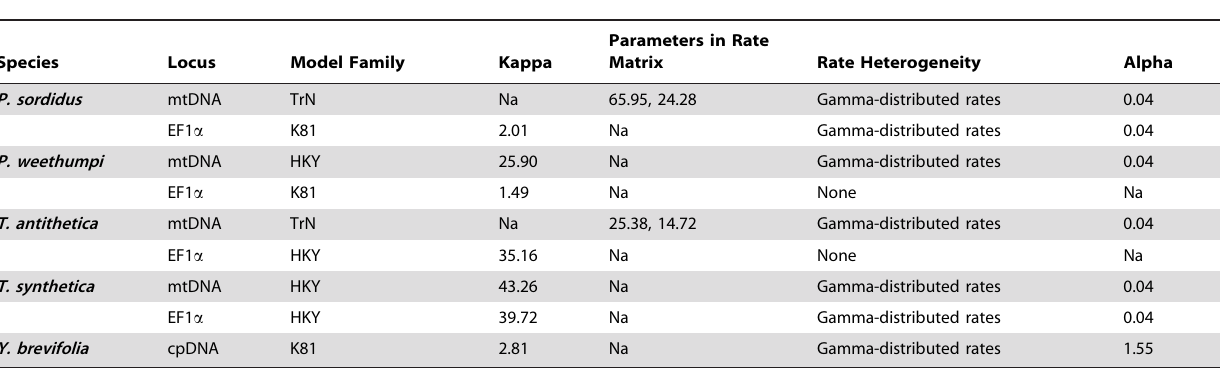
Table 1. Models of sequence evolution inferred using FindModel under AIC.